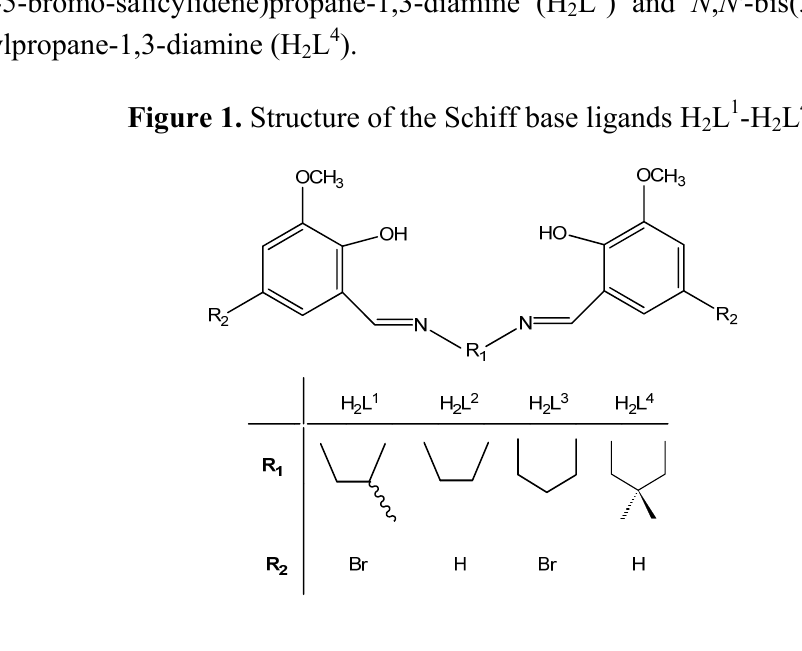
Figure 1. Structure of the Schiff base ligands H